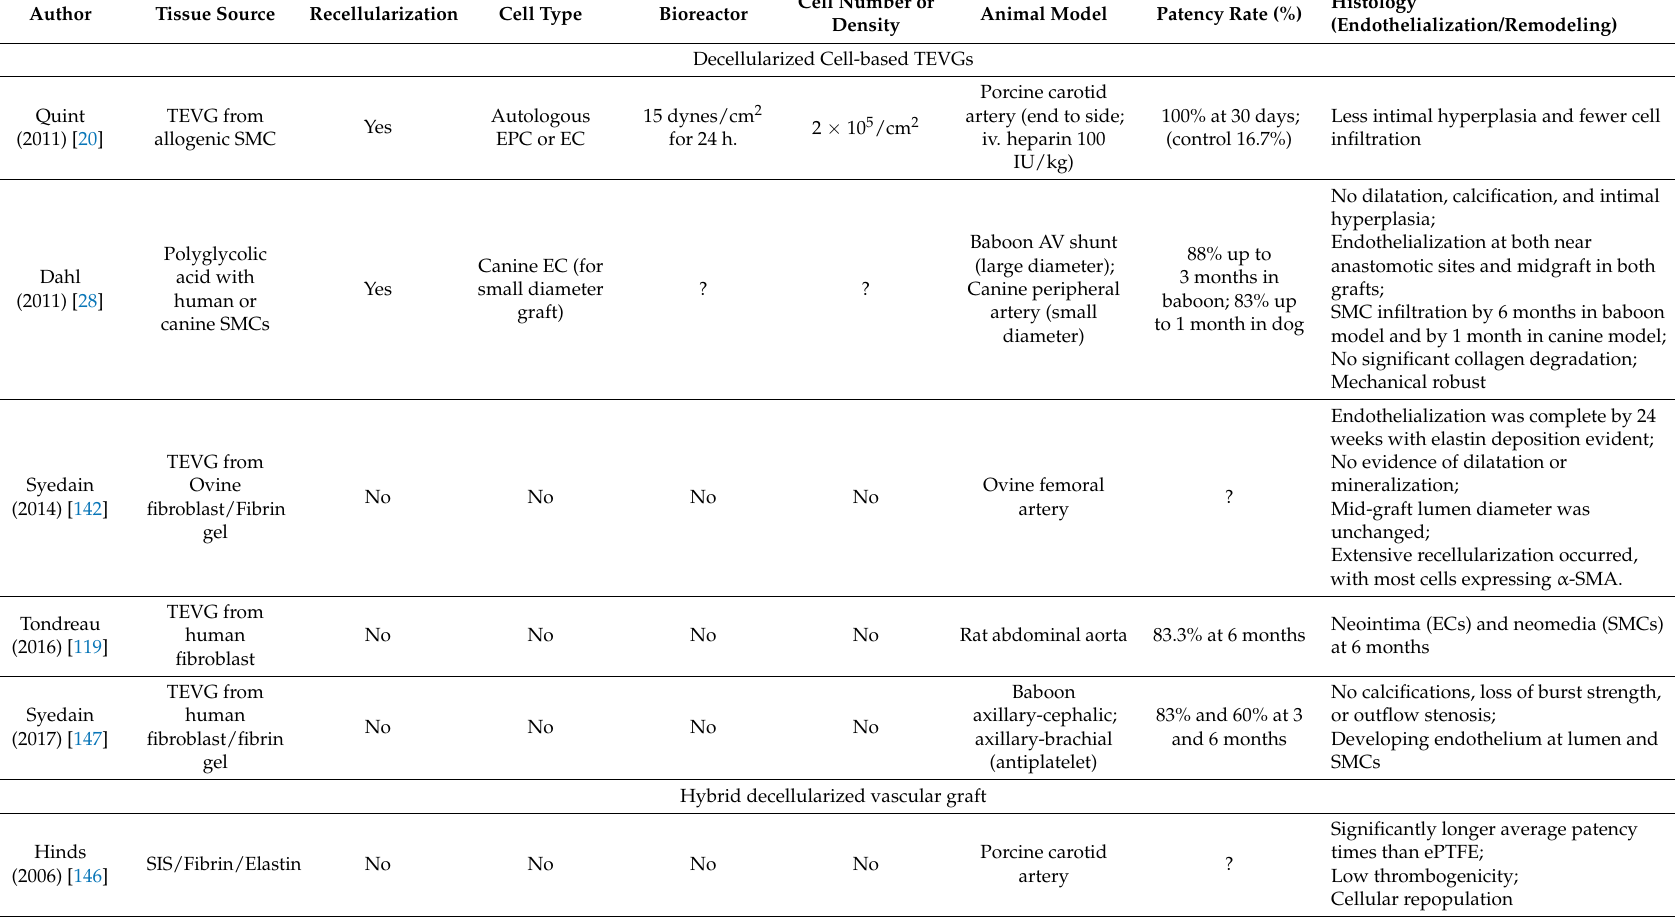
Table 5. Summary of in vivo performance of variant-decellularized vascular grafts since